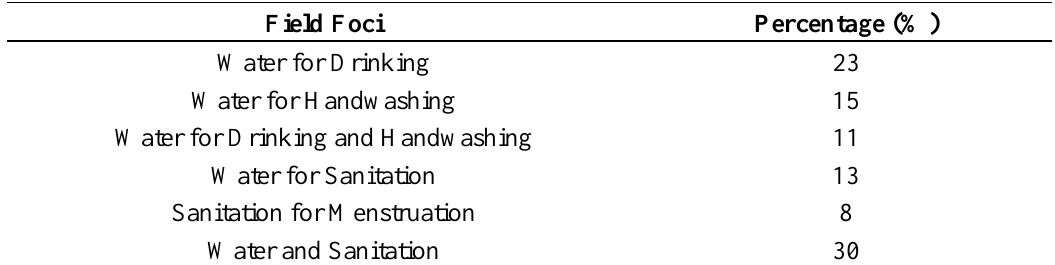
Table 1. Field Foci addressed in included papers (n = 47). Percentages rounded to the nearest whole